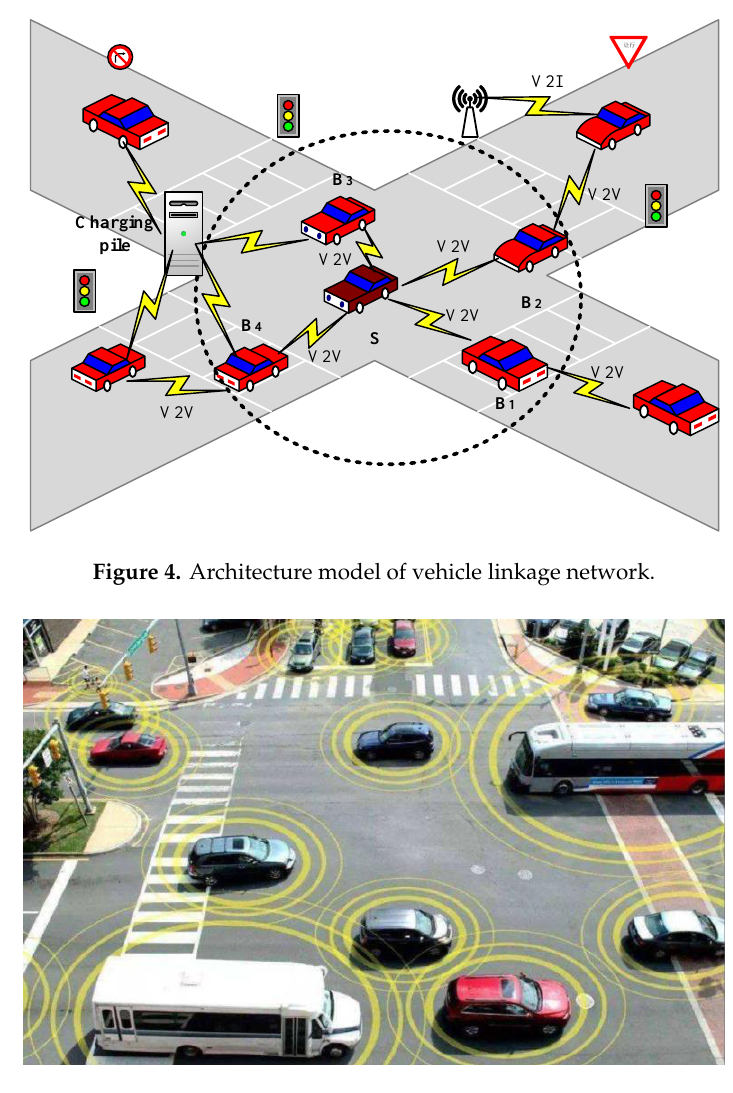
Figure 5. Live diagram of vehicle linkage network.